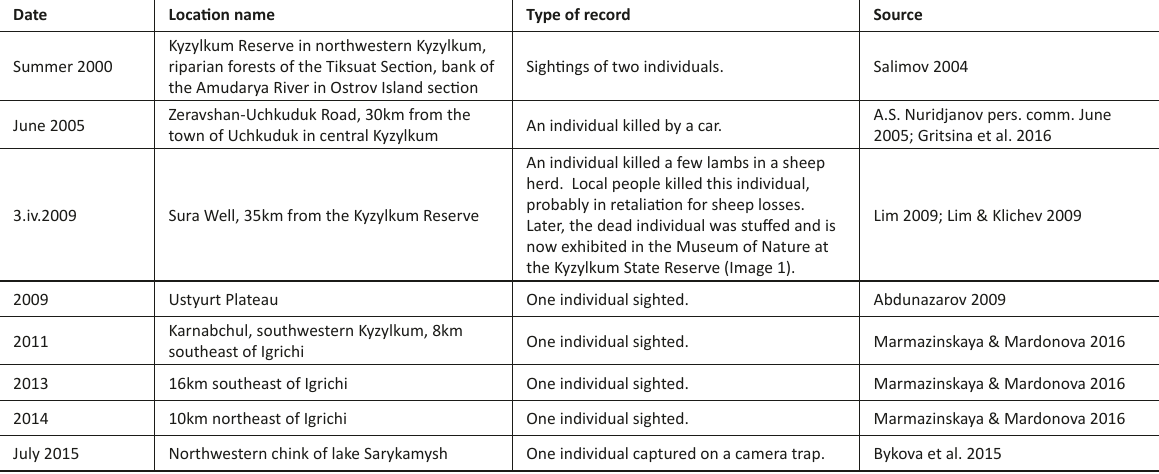
Table 1. Caracal records in Uzbekistan published between 2000 and